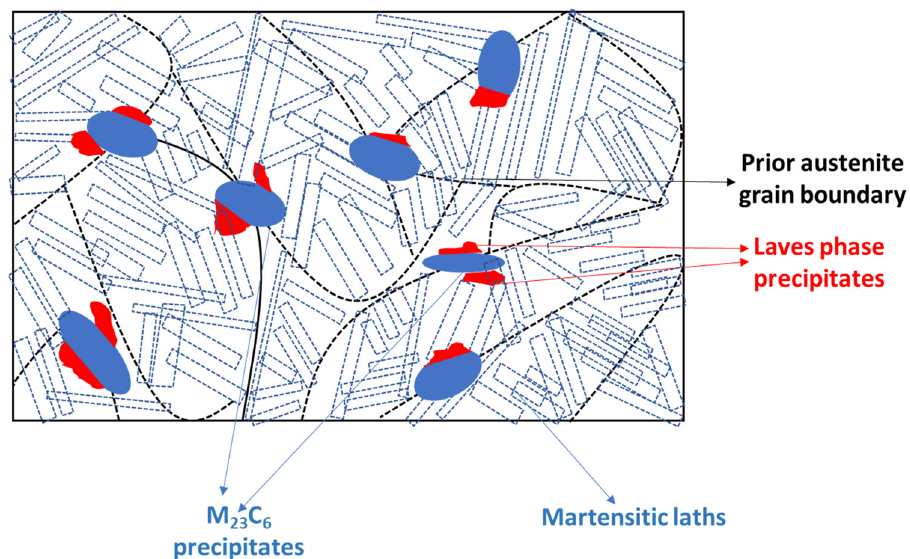
Figure 4: Schematic showing the growth of the Laves phases around M 23 C 6